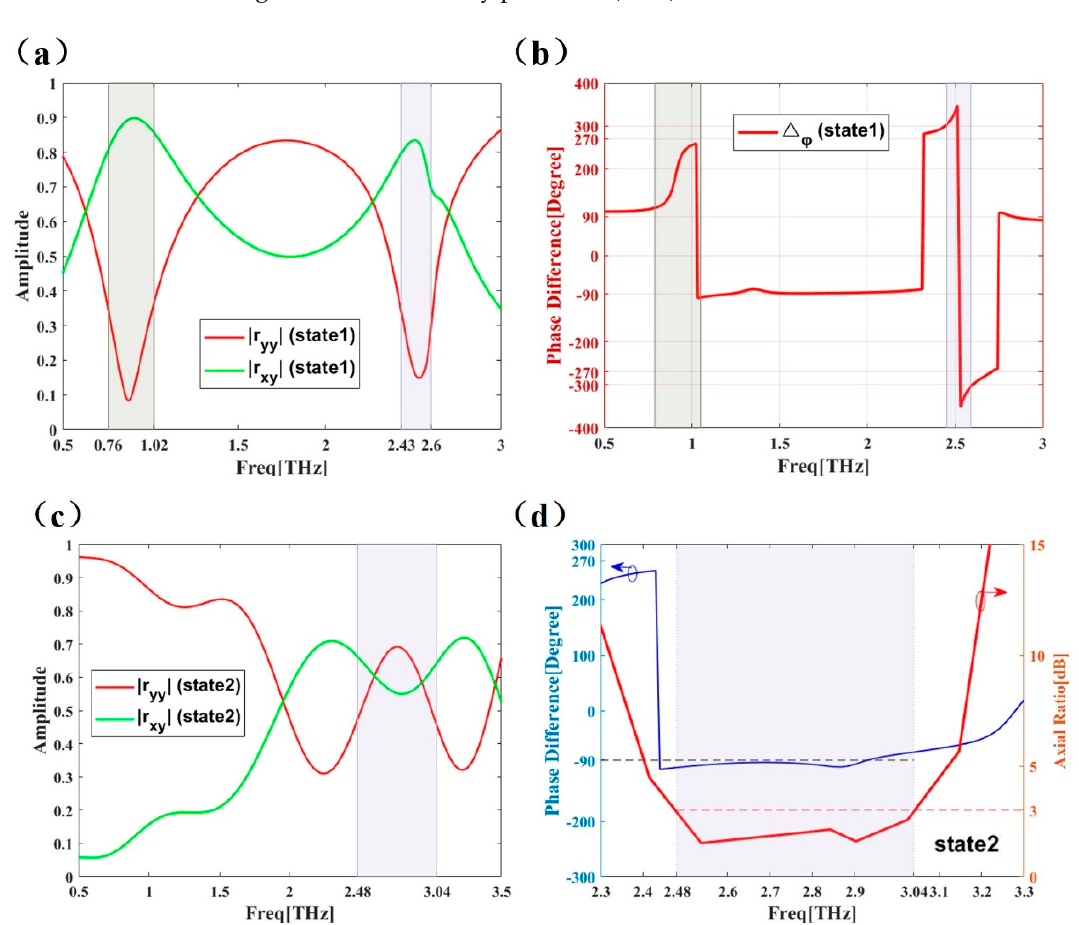
Figure 4. The |r| yy and |r| xy amplitude of the PCM unit at state 1 (0.0 eV) ( a ) and state 2 (0.5 eV) ( c ). The phase difference ∆ φ xy of PCM unit’s |r| yy and |r| xy at state 1 (0.0 eV) ( b ) and state 2 (0.5 eV) ( d ). Axial ratio of PCM unit at state 2 (0.5 eV) (𝐝) .